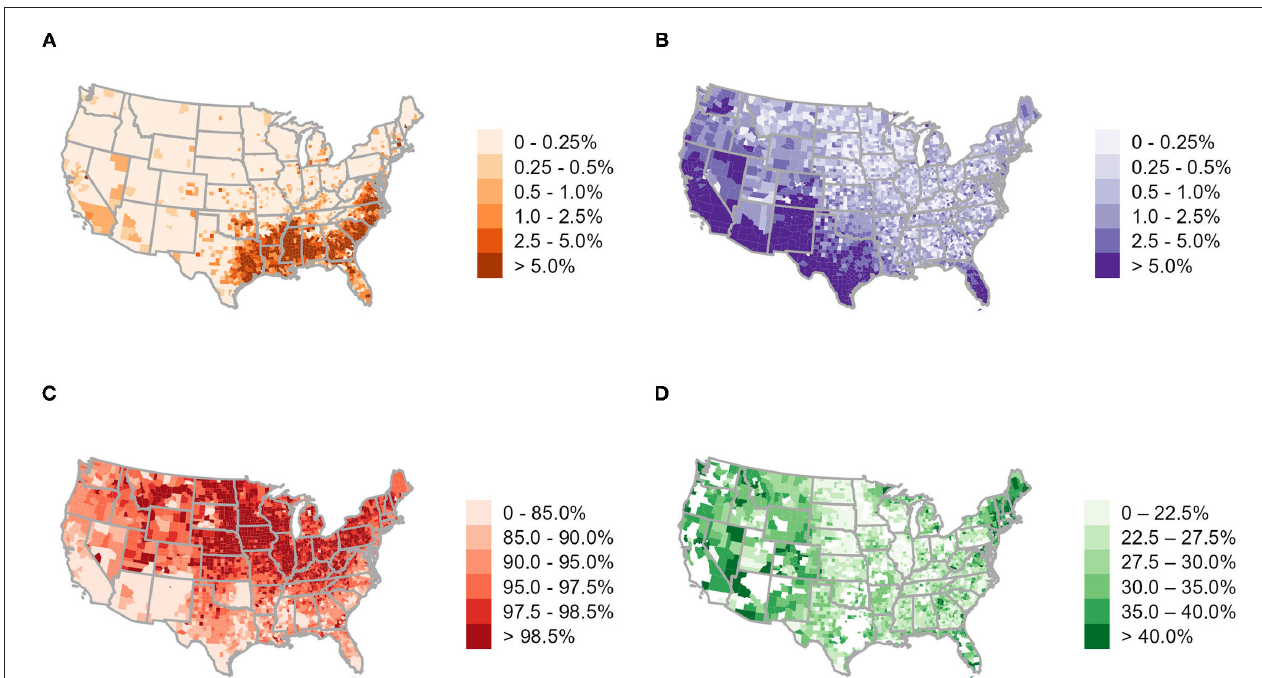
FIGURE 4 | Percent principal operators identifying as (A) Black, (B) Hispanic, (C) white, and (D) female in 2017. Note, (B) includes all farmers identifying their ethnicity as Hispanic (i.e., includes all races) (C) includes both Hispanic and non-Hispanic identifying operators. Data A − C,D : USDA NASS